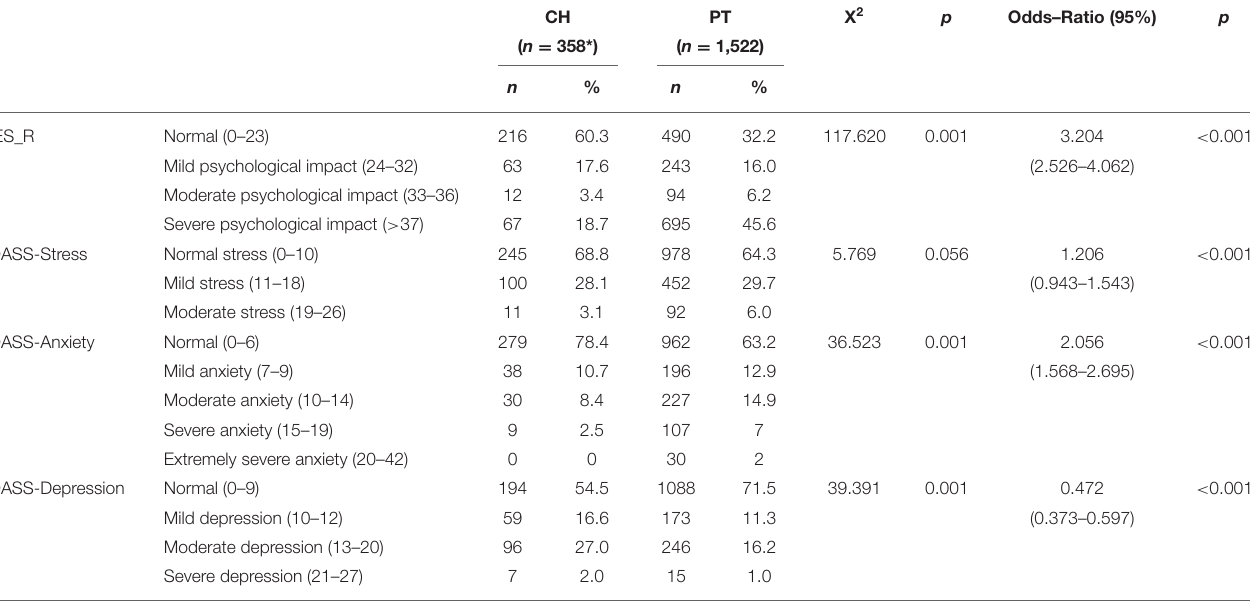
TABLE 3 | Prevalence of mental health symptoms and psychological impact between the two countries (Portugal vs. Switzerland; n = 1,880). CH PT X 2 p Odds–Ratio